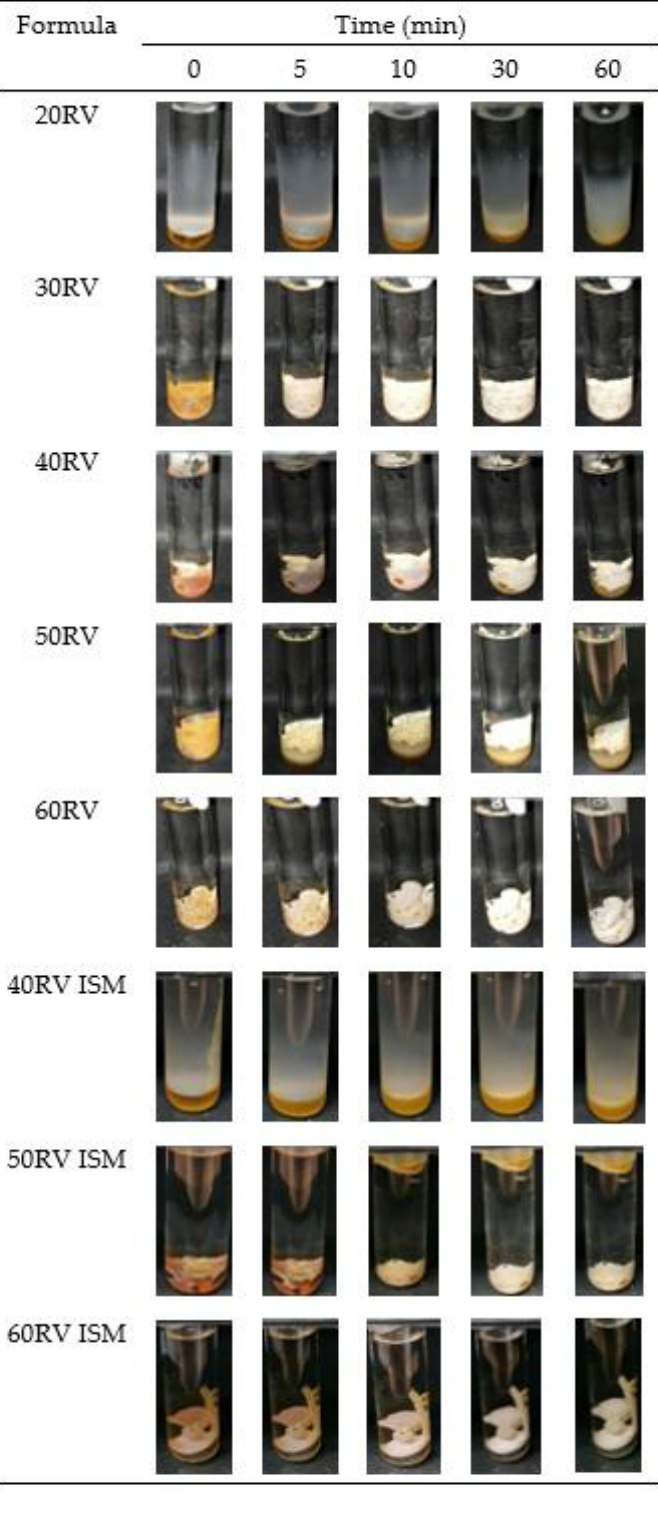
Figure 2. Macroscopic transformation of vancomycin HCl-loaded ISG and ISM containing 20–60% ( w / w ) rosin in PBS pH 6.8 at different times.